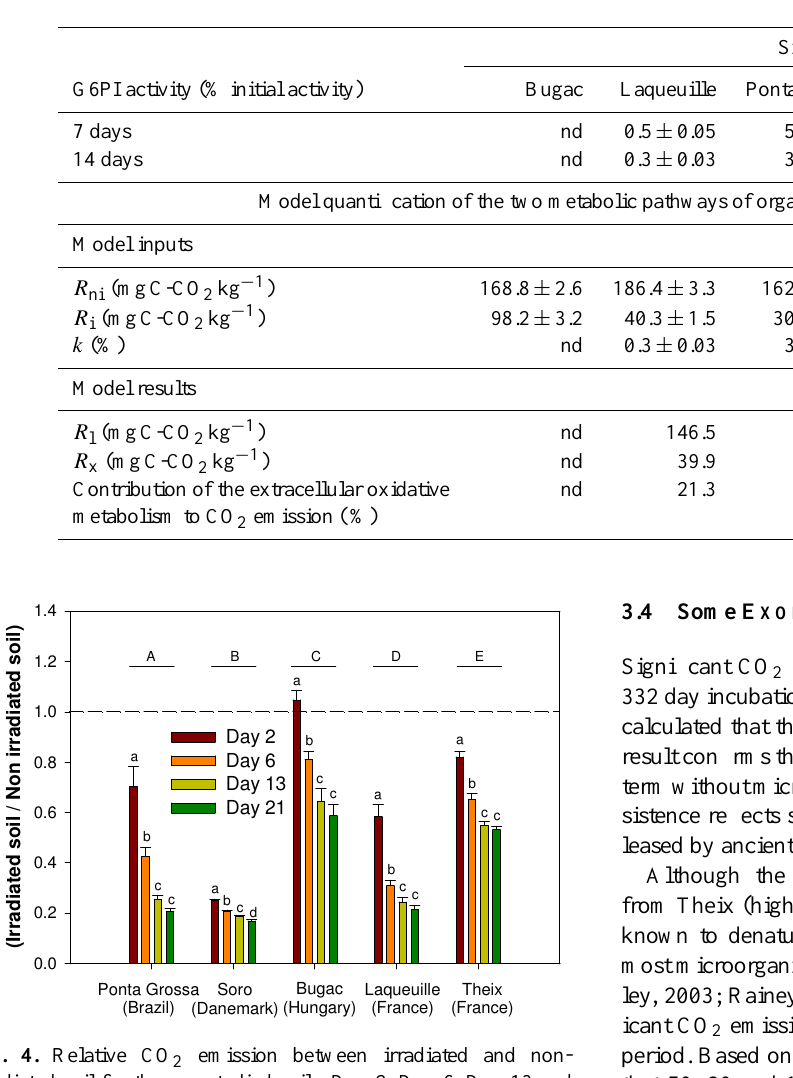
Table 3. Activity of glucose-6-phosphate isomerase (G6PI) and model quantification of CO 2 emissions from living organisms ( R l ) and extracellular oxidative metabolism ( R x ) for the five studied soils. R ni and R i represent CO 2 emissions from non-irradiated and irradiated soil, respectively, for the incubation period 13–21 days. k is the fraction of R l converted in extracellular oxidative metabolism (E XOMET ) after irradiation. Contribution (%) of E XOMET to soil CO 2 emission was calculated as R x / R ni · 100. nd=not determined